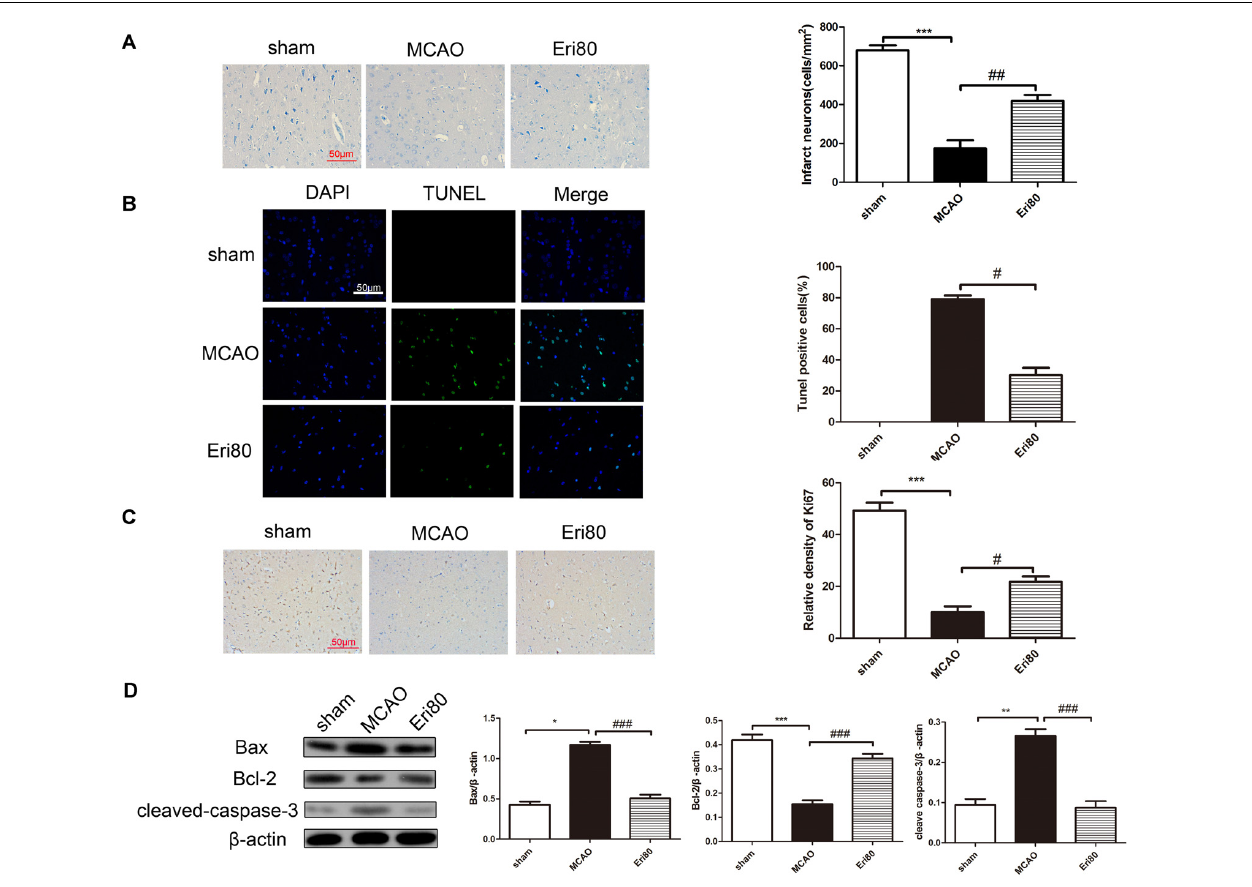
FIGURE 3 | Eriodictyol inhibited the neuronal loss and apoptosis in MCAO rats. (A) Effects of eriodictyol on neuronal loss were detected by Nissl staining. (B) Apoptosis was evaluated by TUNEL staining. TUNEL-positive signal was shown in green and DAPI was shown in blue. Scale bar: 50 µ m. (C) Ki67 expression was evaluated by immunohistochemical staining. Scale bar: 50 µ m. (D) The protein expression were assessed via western blotting assay and analyzed by ImageJ software. The bands are represented for the expression of Bax, Bcl-2, and cleaved-caspase-3, which were normalized to β -actin (The data are presented as mean ± SEM, n = 3 each group, * P < 0.05, ** P < 0.01, *** P < 0.001, vs. sham group; # P < 0.05, ## P < 0.01, ### P < 0.001, vs. MCAO